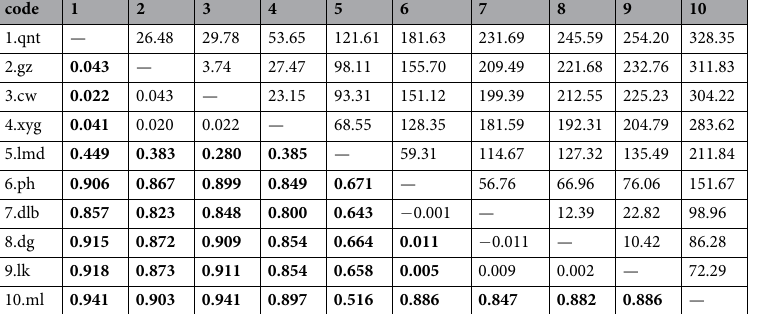
Table 4. Slatkin pairwise F ST values among all sampling localities of C. macropterus populations. Bold numbers are significant values under α = 0.05. Above diagonal are geographic distances between populations